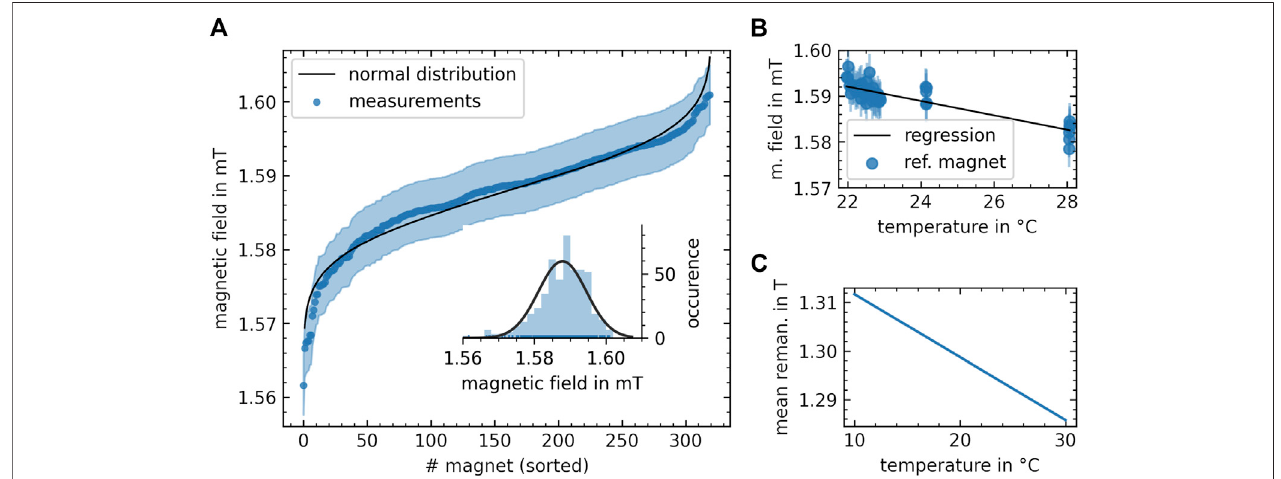
FIGURE 5 | Experimental characterization of individual shim magnets used for populating the shim inserts. (A) Magnetic fi eld measurements for each individual magnet represented by a blue dot. The error is displayed with an opaque blue band. In the inset, a histogram of the distribution of the magnetic fi eld amplitudes is displayed. Quanti fi cation of the effective remanence of the shim magnets. (B) Magnetic fi eld measurements of the reference magnet at different temperatures with regression fi t to determine the temperature coef fi cient of the magnet. (C) Resulting temperature dependence of the mean effective remanence of all magnets calculated based on the temperature coef fi cient of the reference